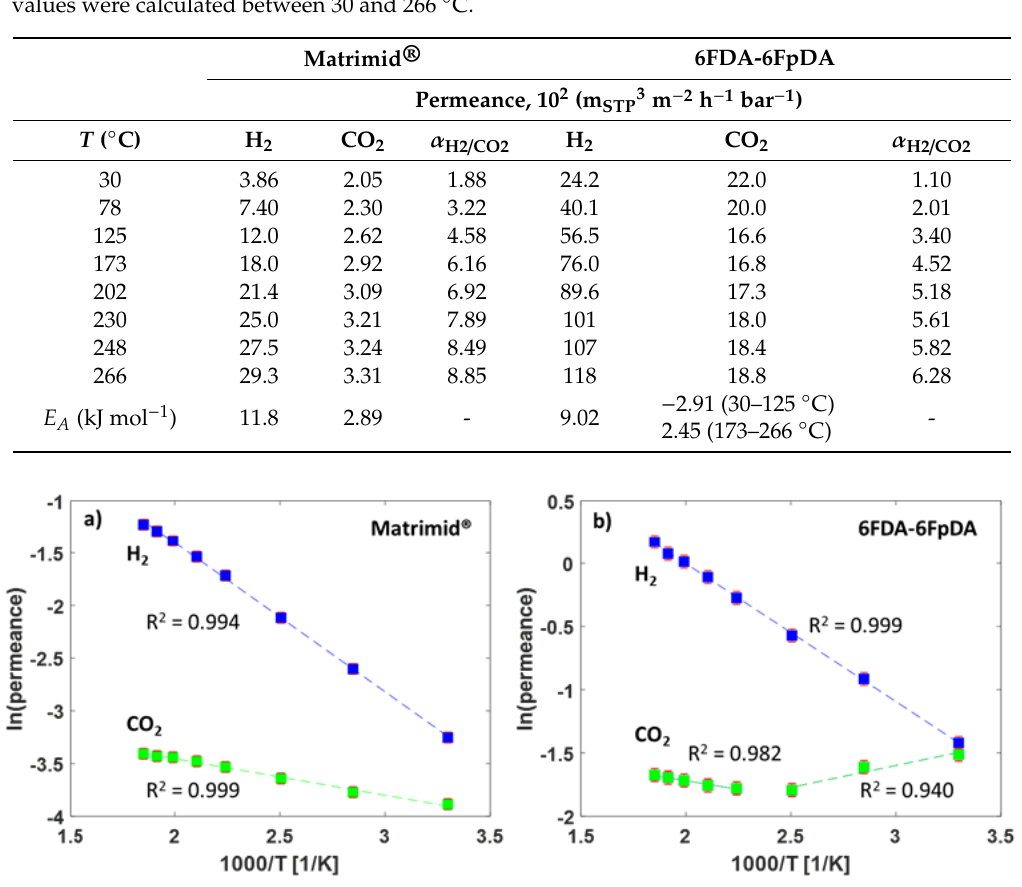
Figure 6. ( a ) Arrhenius plot for the TFCMs of Matrimid ® and ( b ) 6FDA-6FpDA for temperatures between 30 and 266 °C.